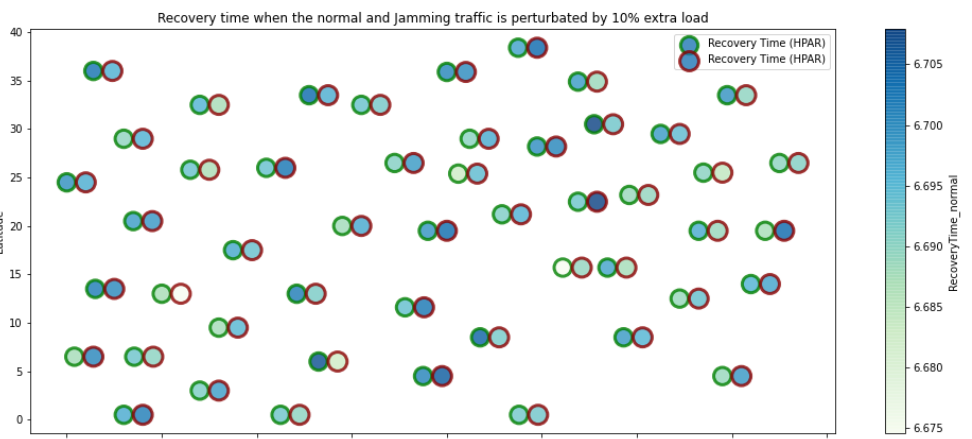
Figure 8. HPAR retransmissions under normal conditions and jamming.